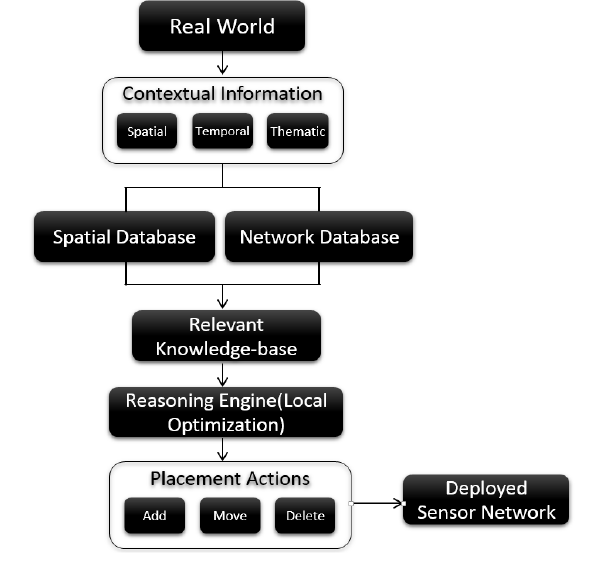
Figure 2: The pseudo-code of the local context-aware